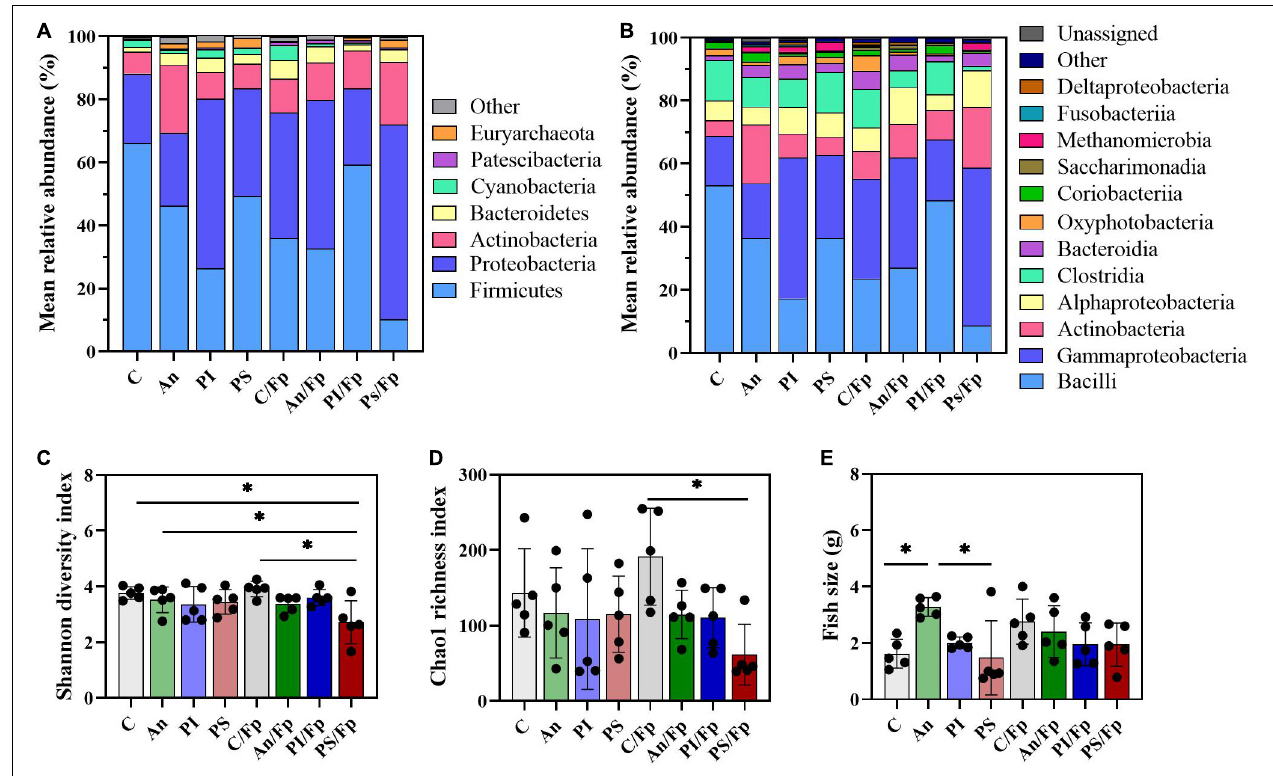
FIGURE 5 | Microbial community at 1 dpi. Characterization of mean relative abundance at phylum (A) and class (B) level, Shannon diversity index (C) , Chao1 richness index (D) , and fish weight (E) . Values represent the mean of five samples. In (C–E) , error bars represent the standard deviation and statistically significant differences are indicated by ∗ (adjusted p -value < 0.05). Shannon diversity index values are based on 10,000 reads per sample. C, control feed group; An, antibiotic feed group; PI, phage-immobilized feed group; PS, phage-sprayed feed group; C/Fp, control feed group + F. psychrophilum ; An/Fp, antibiotic feed group + F. psychrophilum ; PI/Fp, phage-immobilized feed group + F. psychrophilum ; PS/Fp, phage-sprayed feed group + F. psychrophilum